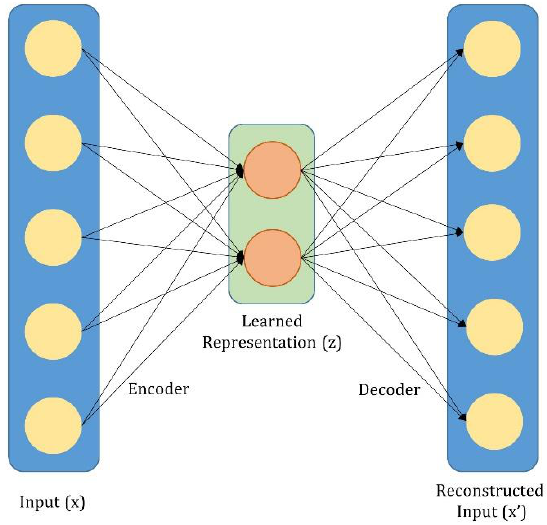
Figure 1. A residual encoder that selects parameters from the input images.